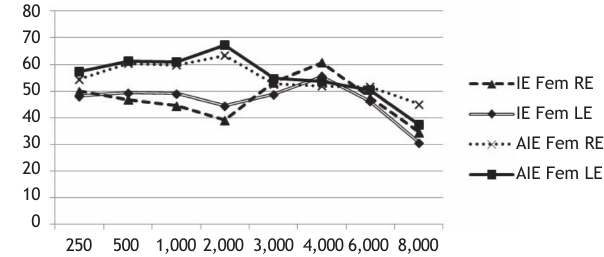
Figure 3 f, resonant frequency; v the ear canal